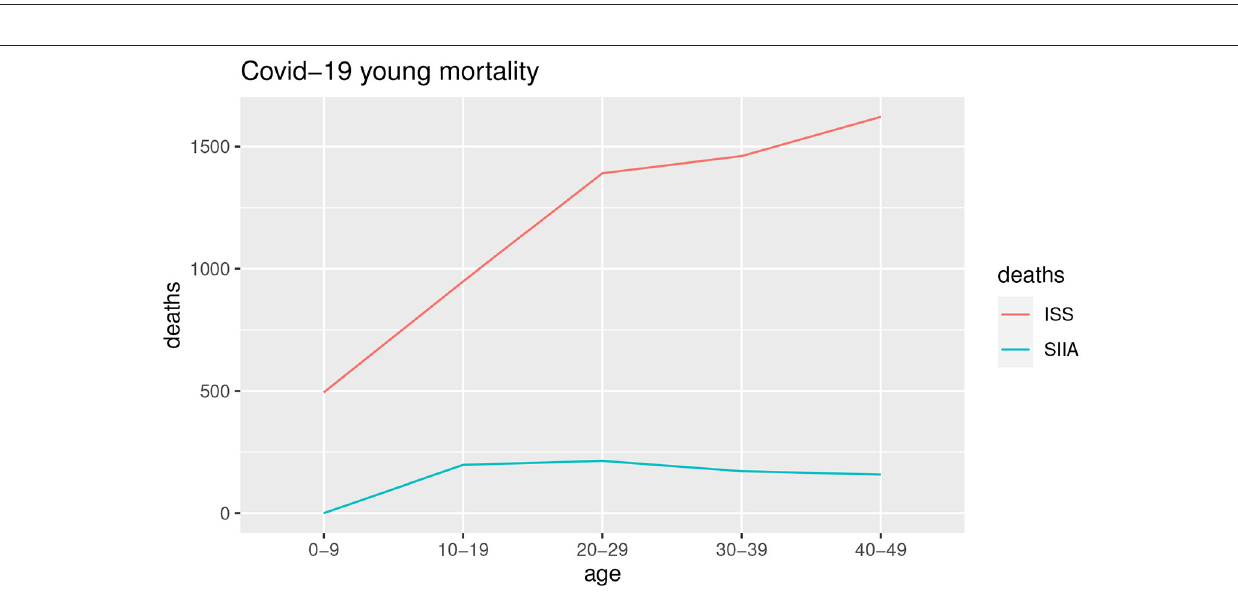
FIGURE 2 | Estimation of all causes of deaths and non-COVID-19 deaths. Adult ages.